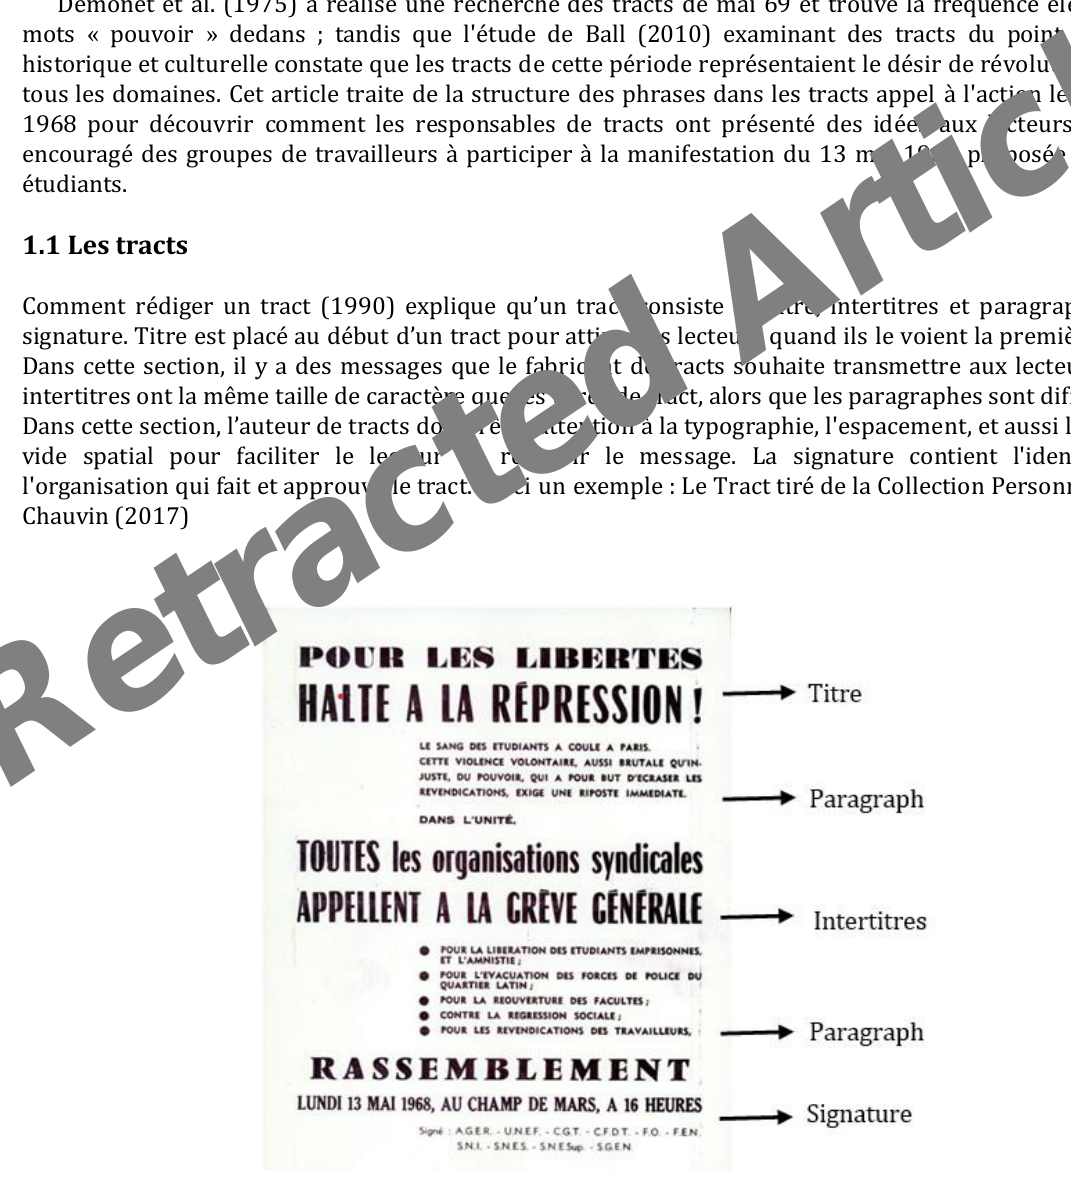
Figure 1 Le Tract tiré de la collection personnelle de Chauvin